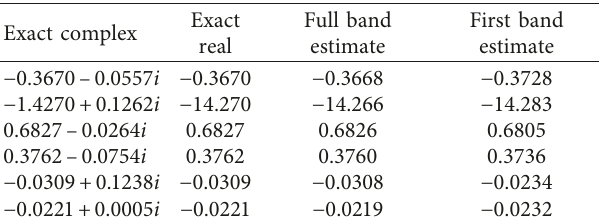
Figure 1: Exact density functions of the simulation case (red) and estimated density functions (blue). Top plot shows the singular values of the spectral density matrix, S ( ω ) , whereas the two bottom plots show the cross spectral density function, g first and second DOFs. The middle plot shows the full band estimate, and the bottom plot shows the band-by-band estimate. Table 2: Modal participation vector estimates for the first mode. Exact Full band First band Exact complex real estimate